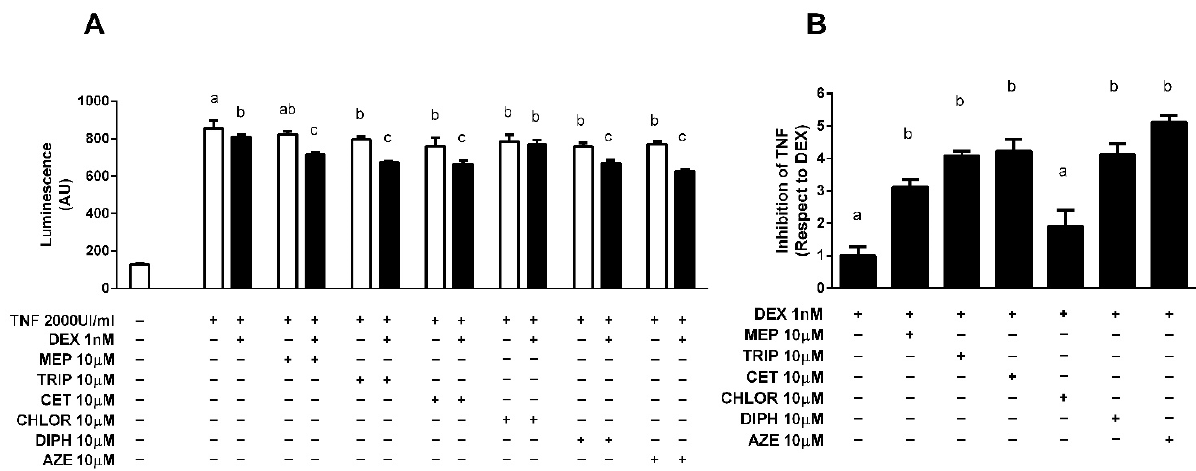
Figure 1. Antihistamines potentiate dexamethasone-induced GR transrepression of a gene-reporter system. ( A ) HEK-293T cells were co-transfected with IL6-Luc, GR and H1R coding constructs and were incubated with 2000 UI/mL TNF- α for 4 h and exposed to 10 µ M antihistamines for 10 min and to 1 nM dexamethasone (DEX) for 24 h (filled black bars) or not (empty white bars), as indicated. ( B ) Data express inhibition of the TNF- α -induced response as fold of the DEX effect. Luciferase activity was determined as described in the methodology section. Results are mean +/ − SD of five independent experiments performed in triplicates. Statistical significance was denoted using letters above bars. Means indicated with a common letter are not significantly different. Likewise, means not sharing any letter are significantly different.